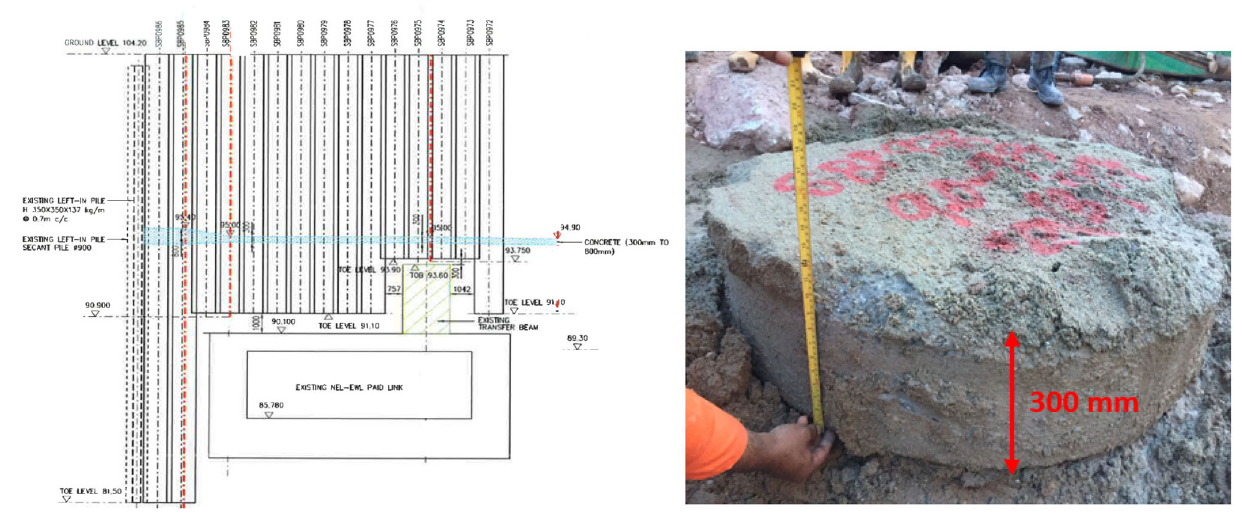
Fig. 7 Obstructed of unknown concrete slab along SBP line